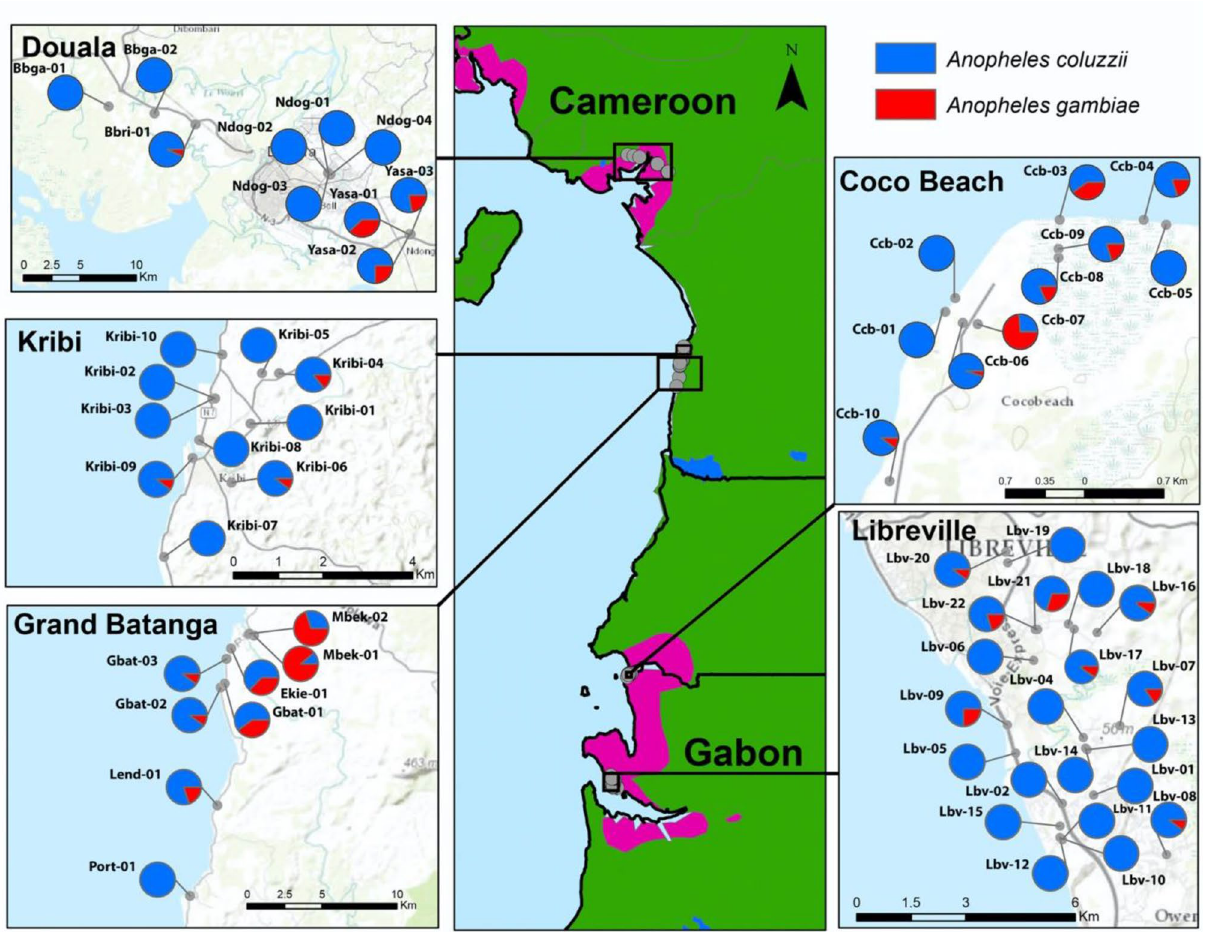
Figure 1. Regional distribution of An. coluzzii and An. gambiae in the collection sites.